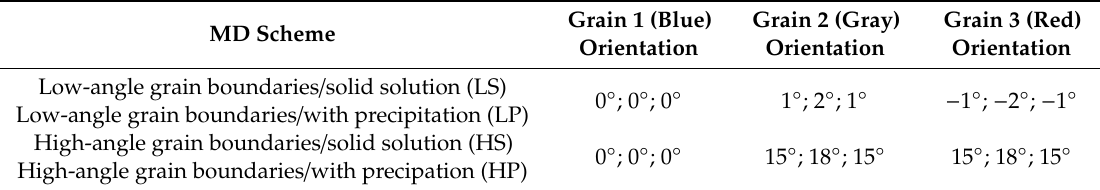
Table 2. MD modeling schemes used in the present